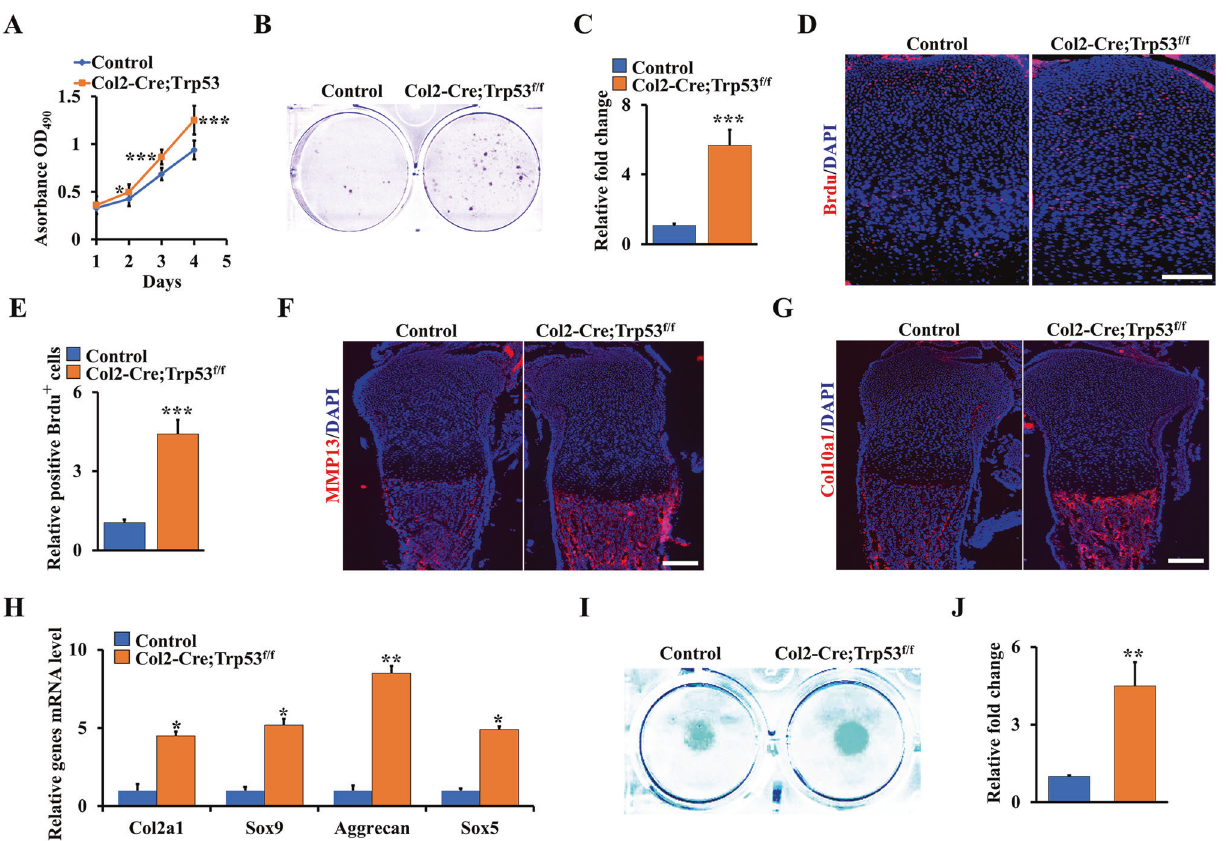
Fig. 4 Trp53 is indispensable for chondrocyte proliferation, matrix production, and maturation. A The proliferation of primary chondrocytes from Col2-Cre;Trp53 f/f mice and controls was identi fi ed at different times as shown by WST-1 assay. B , C Colony formation ( B ) and quantitative analysis of the colony numbers as shown ( C ). D , E BrdU staining (D) and quantitative analysis of BrdU + cells ( E ) in the tibiae from Col2-Cre;Trp53 f/f mice and control at P0. Scale bars, 25 μ m. F MMP13 staining at P0 tibiae as indicated. Scale bars, 75 μ m. G Representative fl uorescence images of Col10a1 at P0 tibiae as indicated. Scale bars, 75 μ m. H The mRNA level of chondrocyte differentiation markers in primary chondrocytes as indicated. I , J The primary chondrocytes were cultured by micromass in chondrogenic medium as indicated. After 7 days ’ culture, the macromass were stained by the alcian blue solution as shown. The relative fold change of intensity was identi fi ed ( J ). * P < 0.05, ** P < 0.01, *** P <